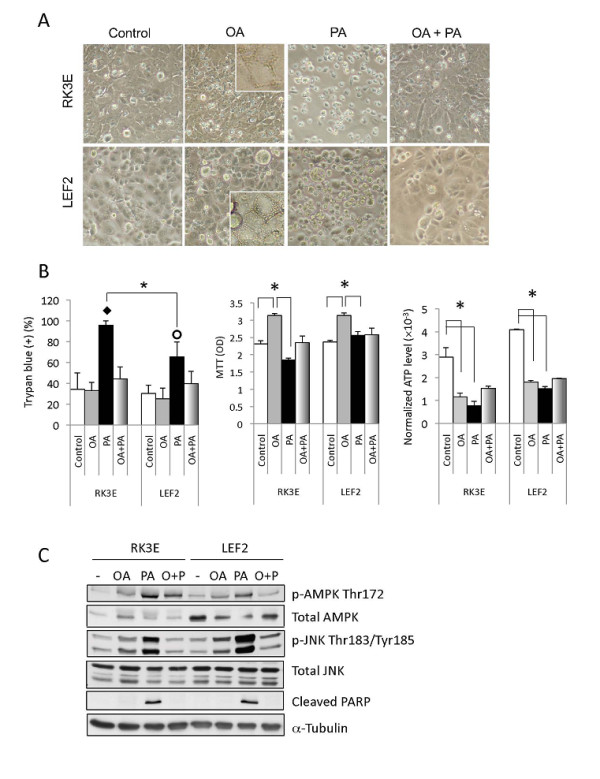
Effects of fatty acids on LEF2 cells. A) Appearance of cells 24 hrs following exposure to oleic acid (OA, 1 mM), palmitic acid (PA, 1 mM), both (OA+PA, 3 mM at 2:1 ratio) or vehicle control. Magnification 10×. Inserts represent higher magnification views showing cytoplasmic vesicles. B) Assessment of cell viability (Trypan blue exclusion), proliferation (MTT), and ATP levels following 6 hours of fatty acids exposure. C) Western blot analyses of cell lysates from each of the four treatments blotted for the indicated proteins. α-tubulin serves as a loading control. For graphs, error bars represent SEM. *, p < 0.05; ◆ indicates p < 0.01 compared to all other groups; O indicates p < 0.05 compared to all other groups.